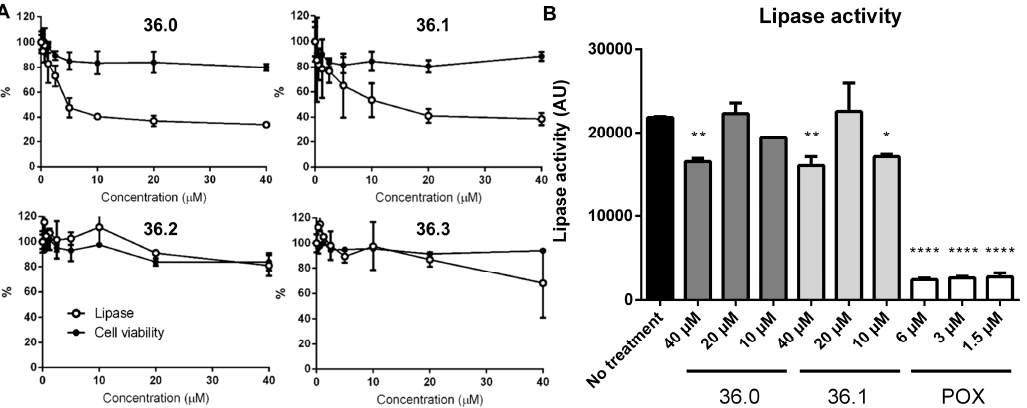
Figure 2. Compound 36 derivatives reduce LipY activity. (A) M. marinum overexpressing lipY and mspA was grown in the presence of test compounds. After 3 days, lipase activity was measured using DGGR as a substrate. Subsequently, cell viability was determined by REMA. (B) M. marinum overexpressing lipY and mspA was incubated with compounds 36.0, 36.1, or lipase inhibitor paraoxon (POX) for 2 hours. Afterward, lipase activity was measured using the lipase assay (DGGR substrate). One-way ANOVA calculated statistical significance with Dunnett post-hoc test by comparing lipase activity from the untreated group with each treatment group (* p ≤ 0.05, ** p ≤ 0.01, **** p ≤ 0.0001).